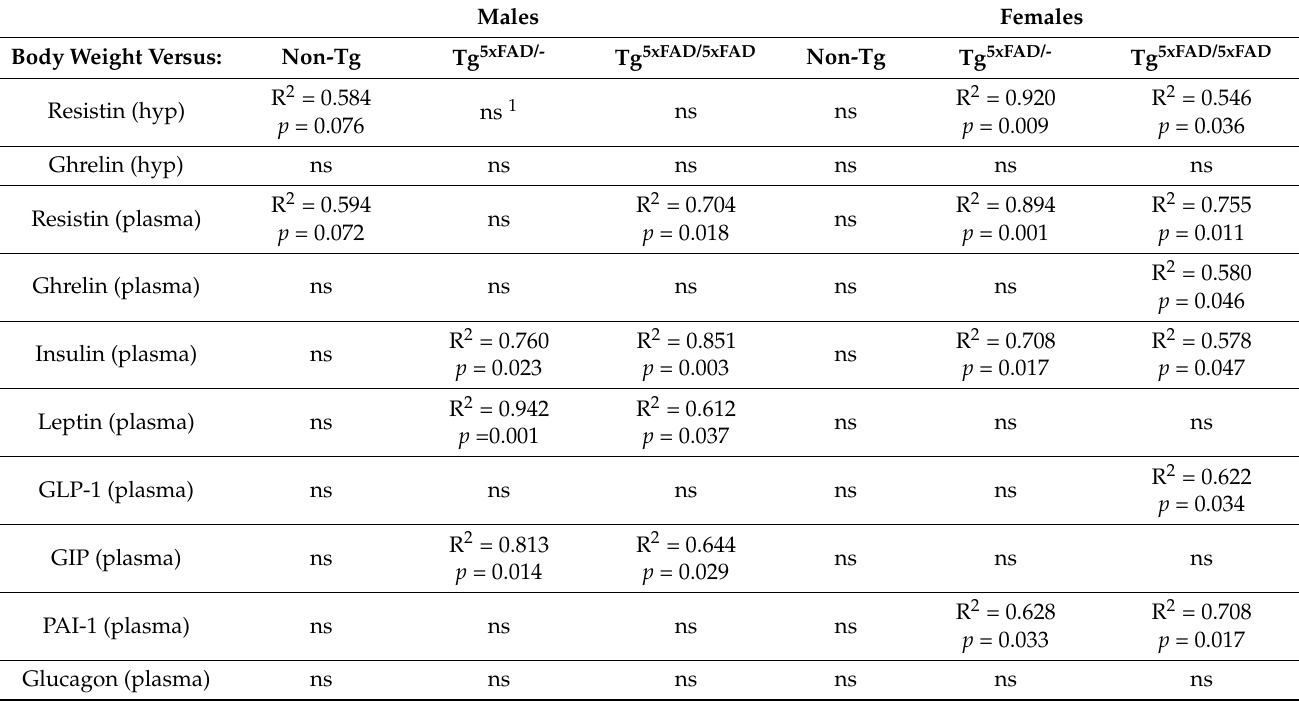
Table 2. Correlations between body weight and hypothalamic and plasma hormones in 5xFAD mice at 6 months of age.